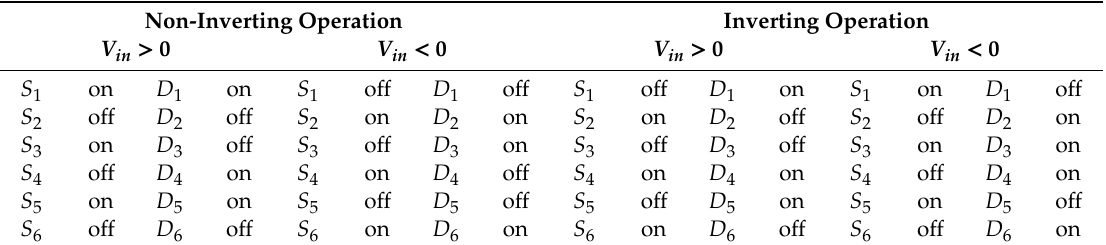
Table1. Theswitchingstatesofthesemiconductordevicesduringnon-invertingandinvertingoperation. Non-Inverting